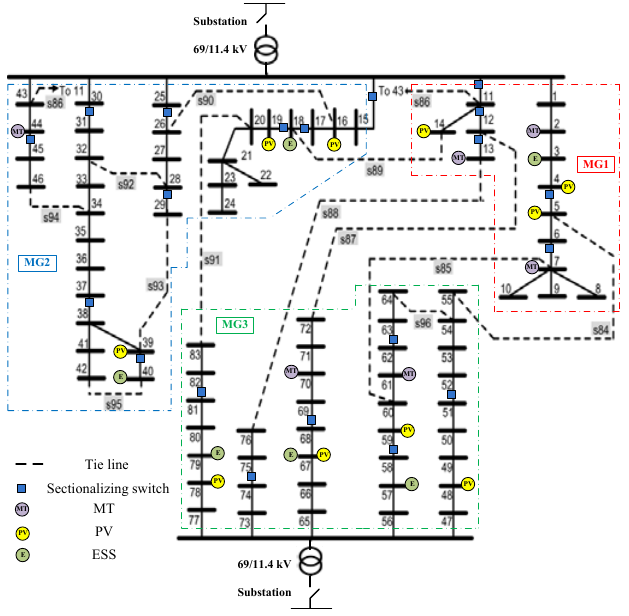
Figure 4. 84-bus Taiwan power company distribution system. Table 1. Values for technical parameters [29].